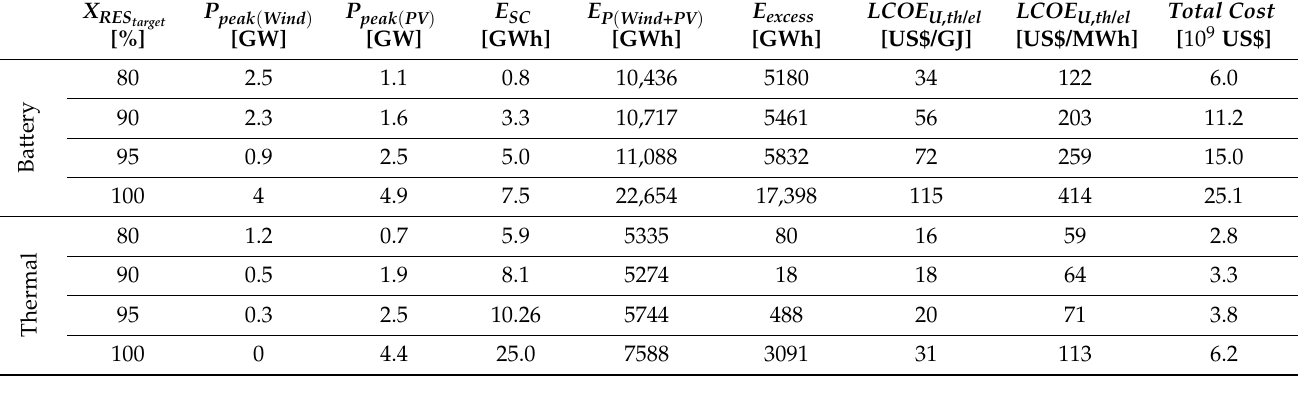
Table 8. Configurations with the upper bound of the LCOE for both storage technologies.